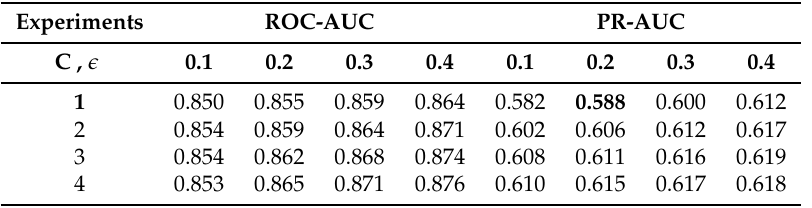
Table 5. ROC and PR of SVR with various parameter C and (cid:101) .